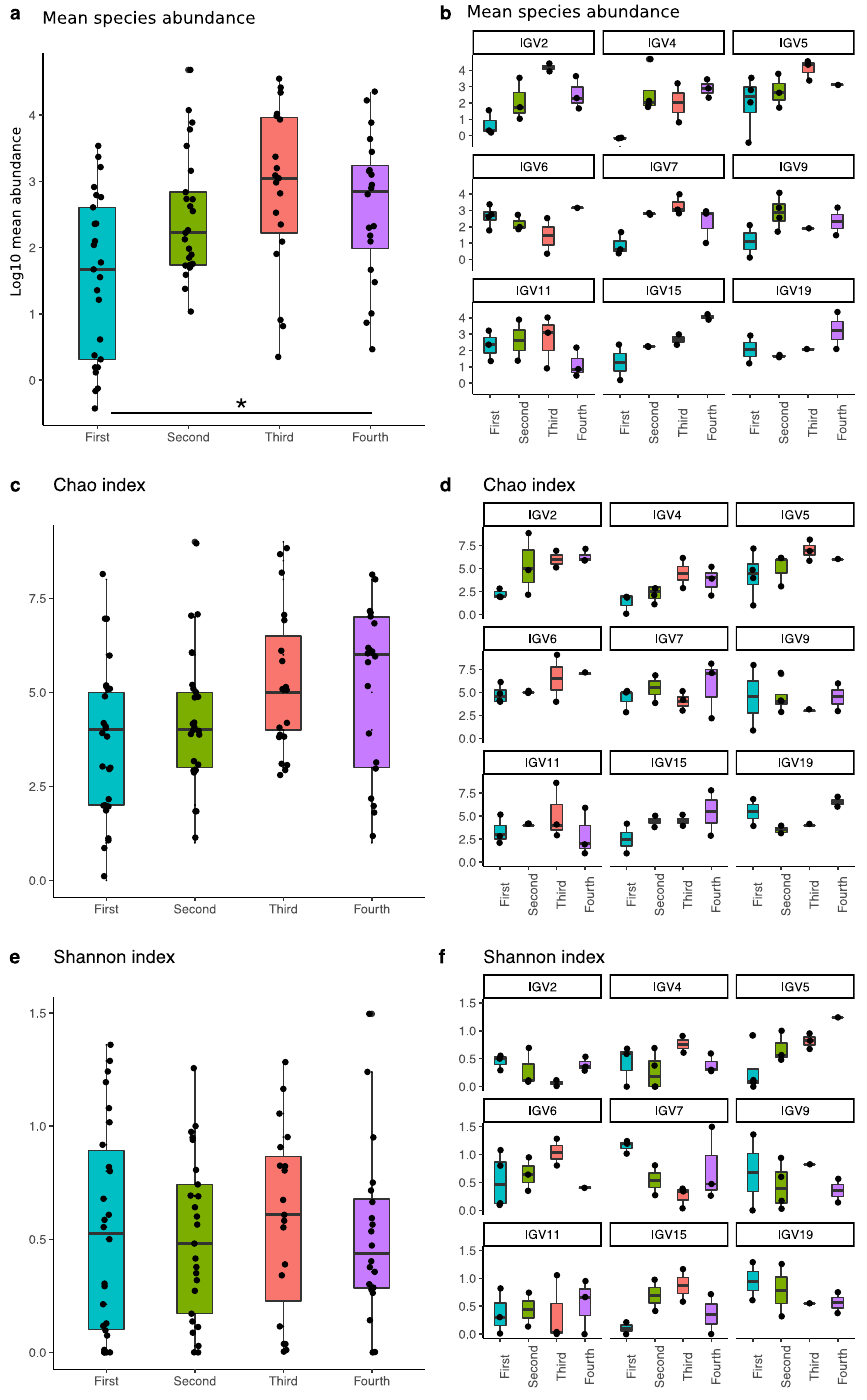
Figure 5. Bar plots comparing human eukaryotic viral diversity measures in fecal samples analyzed by trimester of life, each point indicates a sample. ( a ) Mean of species abundance in all children samples, expressed in logarithm base 10; *Represent p < 0.005 for paired comparisons; ( b ) Mean of species abundance per child, expressed in logarithm base 10; ( c ) Number of species in all children samples, calculated by the Chao richness index; ( d ) Chao richness index in each child; ( e ) Virus diversity in all children samples, calculated with the Shannon diversity index; ( f ) Shannon index of samples per child. In graphs ( b ), ( d ), and ( f ) the identifier IGV (infant gastric virome) is at the top, and each quarter is indicated at the